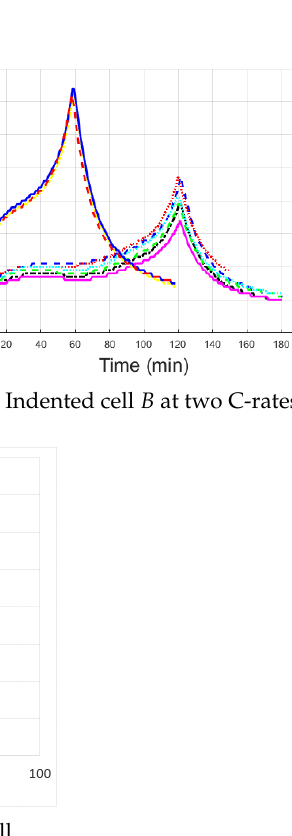
Figure 2. ( a ) Voltage-capacity curves for cells A - D during discharge, cycle 05, ( b ) Voltage-capacity curves for cells A - D during discharge, cycle 89.